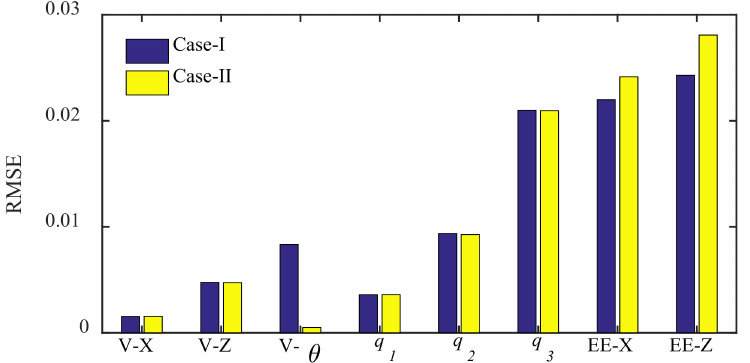
Figure 19. The RMSE of the vehicle, the manipulator, and end